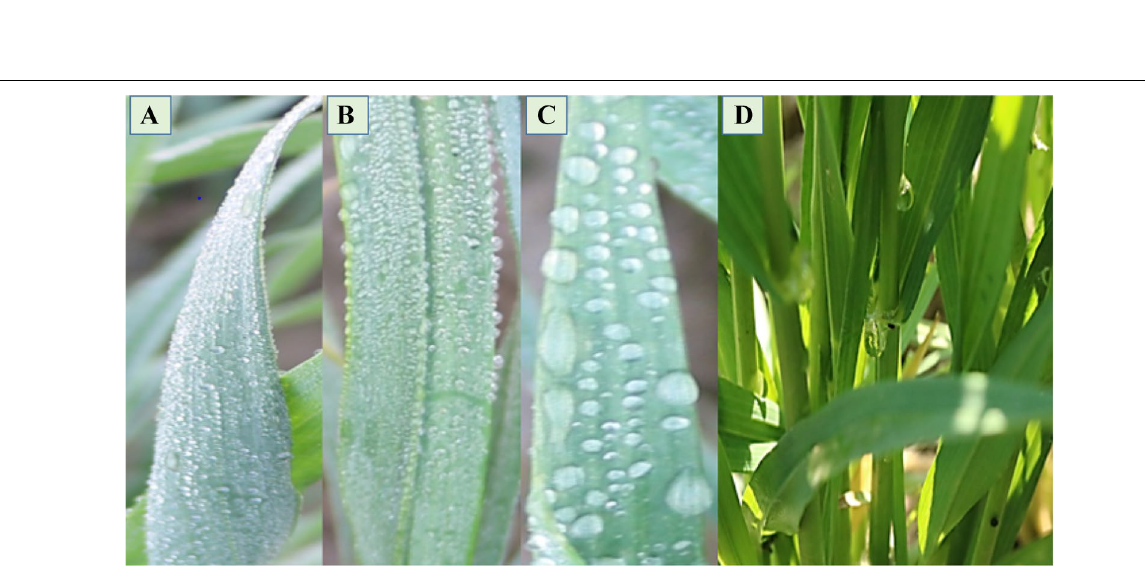
Fig. 3 Fog capturing and transport of droplets, fine droplets on A abaxial and B adaxial leaf surfaces, C progressive droplet growth and coalesce with each other, and D moving toward the base by stem